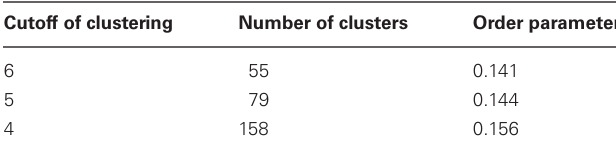
Table 1 | Order parameter estimated for the MD ensemble of Sic1 KID using three different cutoff values.